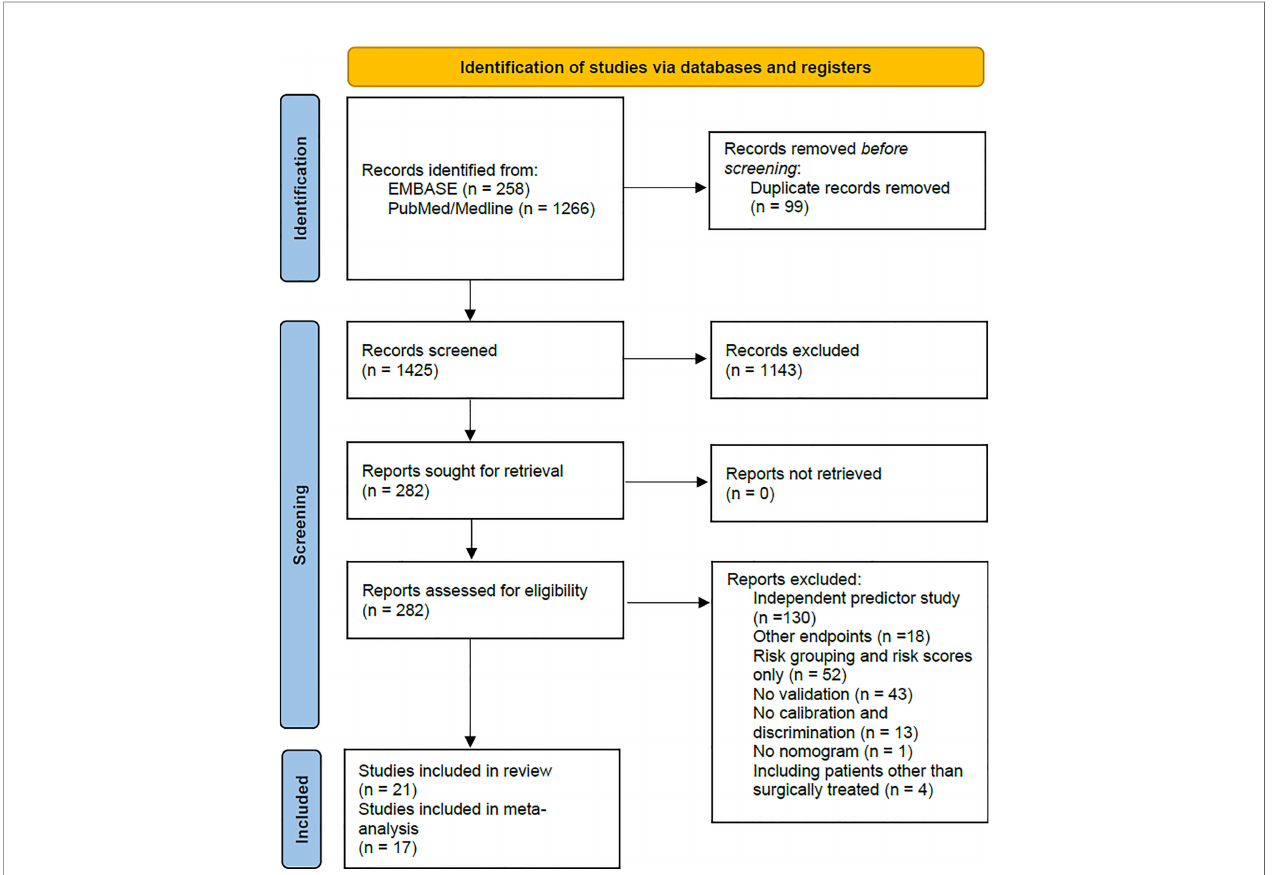
FIGURE 1 | This fi gure shows the PRISMA fl ow chart of the study selection process. From: Page et al.